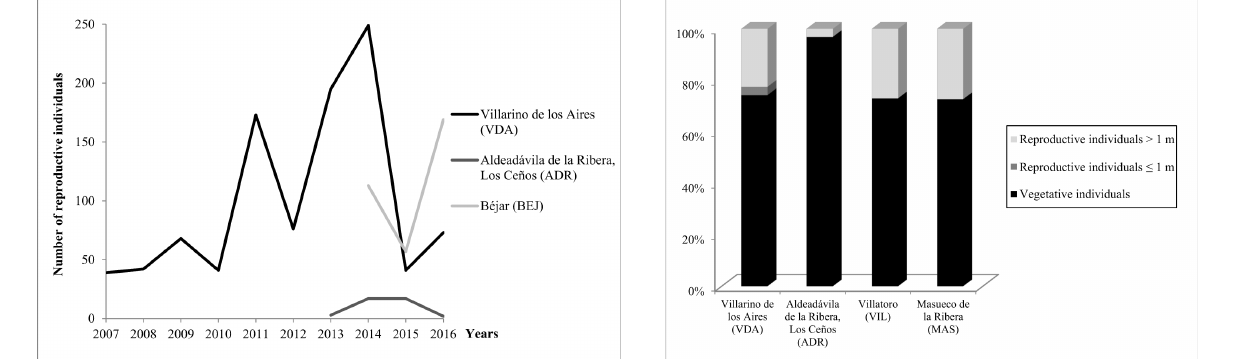
Figure 2. Variation in the number of reproductive Figure 3. Population structure (percentages of vegetative individuals of Delphinium fissum subsp. sordidum for individuals, reproductive individuals with a height less the subpopulations of Villarino de los Aires (VDA), or equal than 1 m and reproductive individuals with Aldeadávila de la Ribera, Los Ceños (ADR) and Béjar a height more than 1 m) of four subpopulations of (BEJ). Delphinium fissum subsp. sordidum